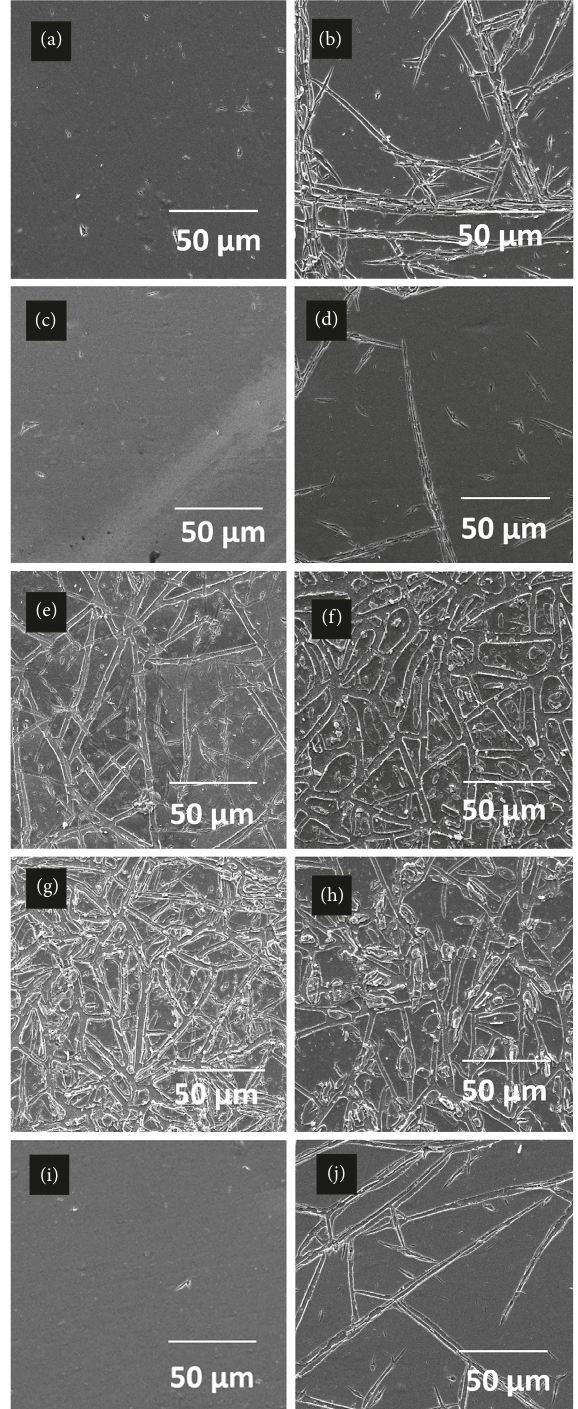
Figure 13: YSZ-coated 430 stainless steel. (a) Edge; (b) center of the sample after four (4) deposition cycles using dip coating. (c) Edge; (d) center of the sample after five (5) deposition cycles using dip coating. (e) Edge; (f) center of the sample after two (2) deposition cycles using dip coating. (g) Edge; (h) center of the sample after three (3) deposition cycles using dip coating. (i) Edge; (j) center of the sample after four (4) deposition cycles using dip